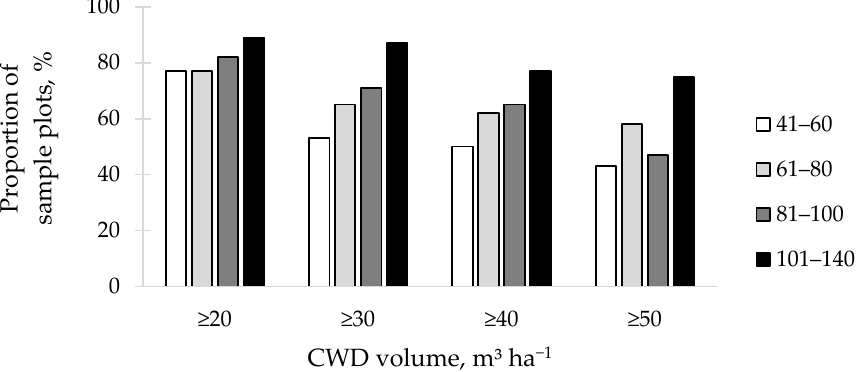
Figure 2. Occurrence of a particular coarse woody debris (CWD) volume according to stand age in unmanaged European aspen ( Populus tremula L.) stands.